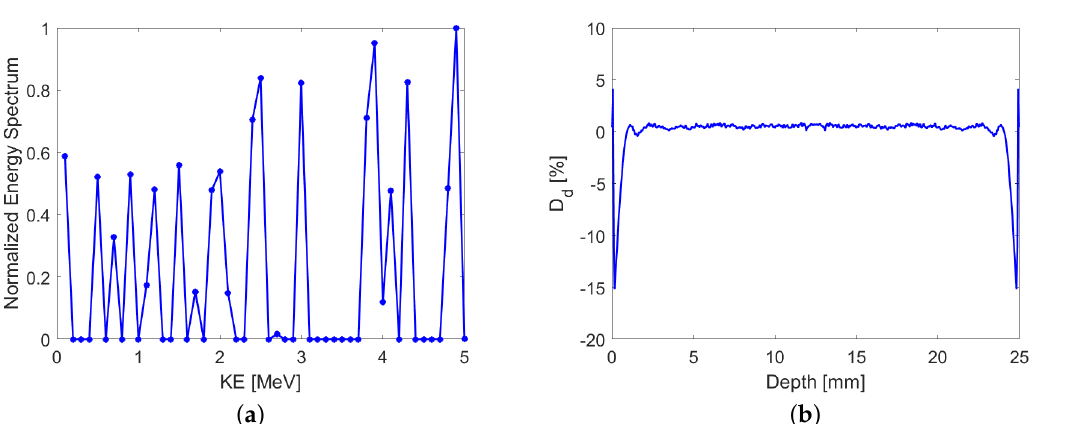
Figure 8. ( a ) The kinetic energy (KE) spectrum and ( b ) the dose deviation, obtained by a least-squares method to provide a uniform depth-dose